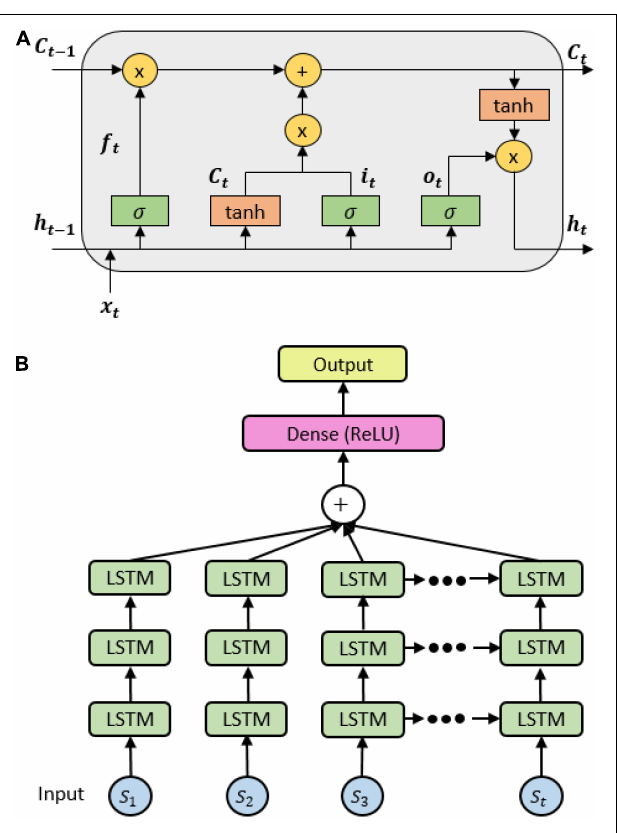
FIGURE 2 | (A) A long short-term memory (LSTM) cell internal mechanism; (B) the stacked LSTM architecture.